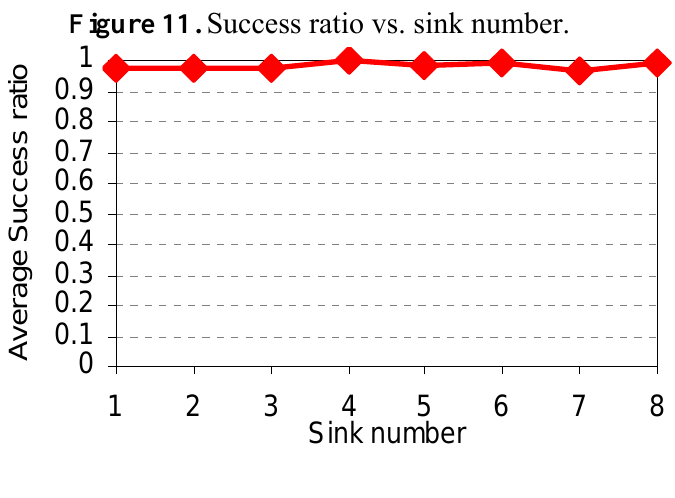
Figure 11. Success ratio vs. sink number.